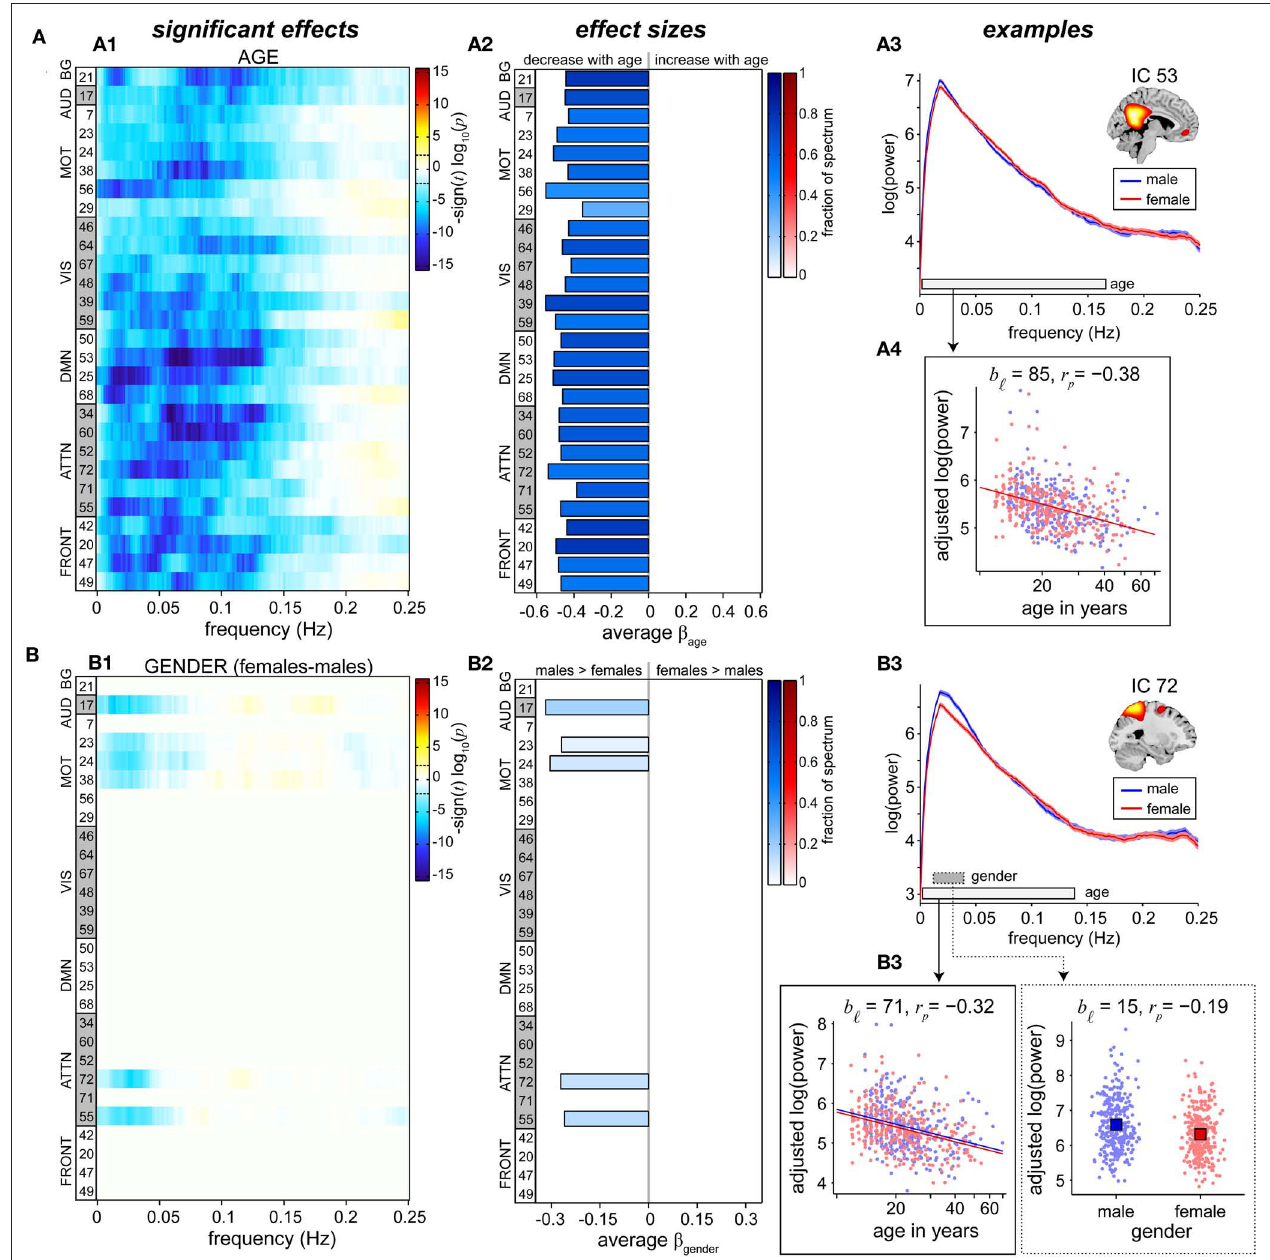
Right panels show examples of components with a sole age effect ( A , IC 53, posterior DMN) and both age and gender effects ( B , IC 72, precuneus). Line plots of the power spectra (A3,B3) show the mean log(power) ± 1 SE for males (blue) and females (red). Horizontal bars on the frequency axis denote bands with significant effects for age (white bar, solid line) and gender (gray bar, dotted line), and correspond to the range over which log(power) was averaged in the scatter plots. Scatter plots (A4, B4) show the covariate of interest versus log(power) after adjusting for nuisance regressors and age (for gender effects). The model fit is shown by colored lines and squares for age and gender, respectively. We indicate the number of frequency bins contributing to the data displayed ( b ) and the partial correlation coefficient ( r )  p between the covariate of interest and